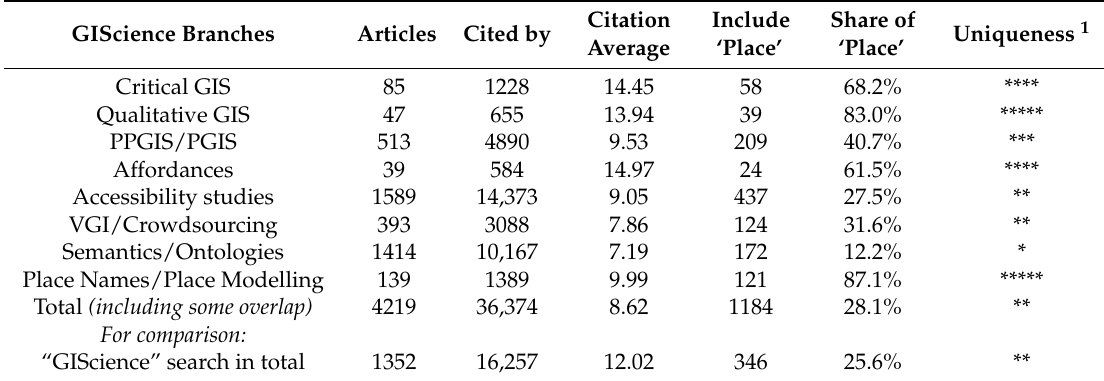
Table 2. Semi-quantitative analysis of the Branches of GIScience research concerned with place in Scopus